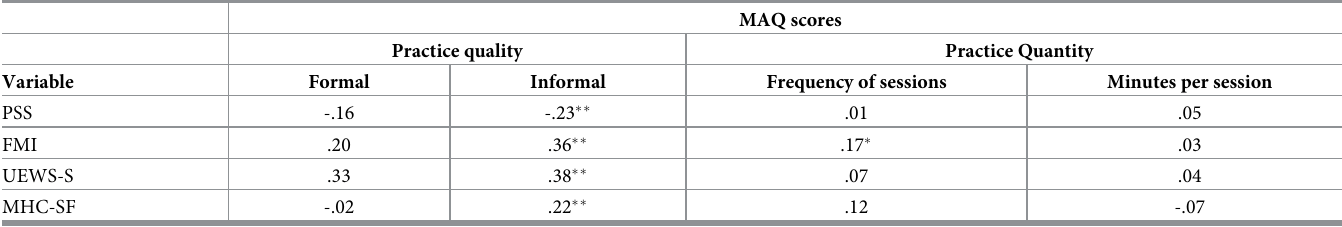
Table 3. Pearson product-moment correlations between change in outcomes and MAQ scores.